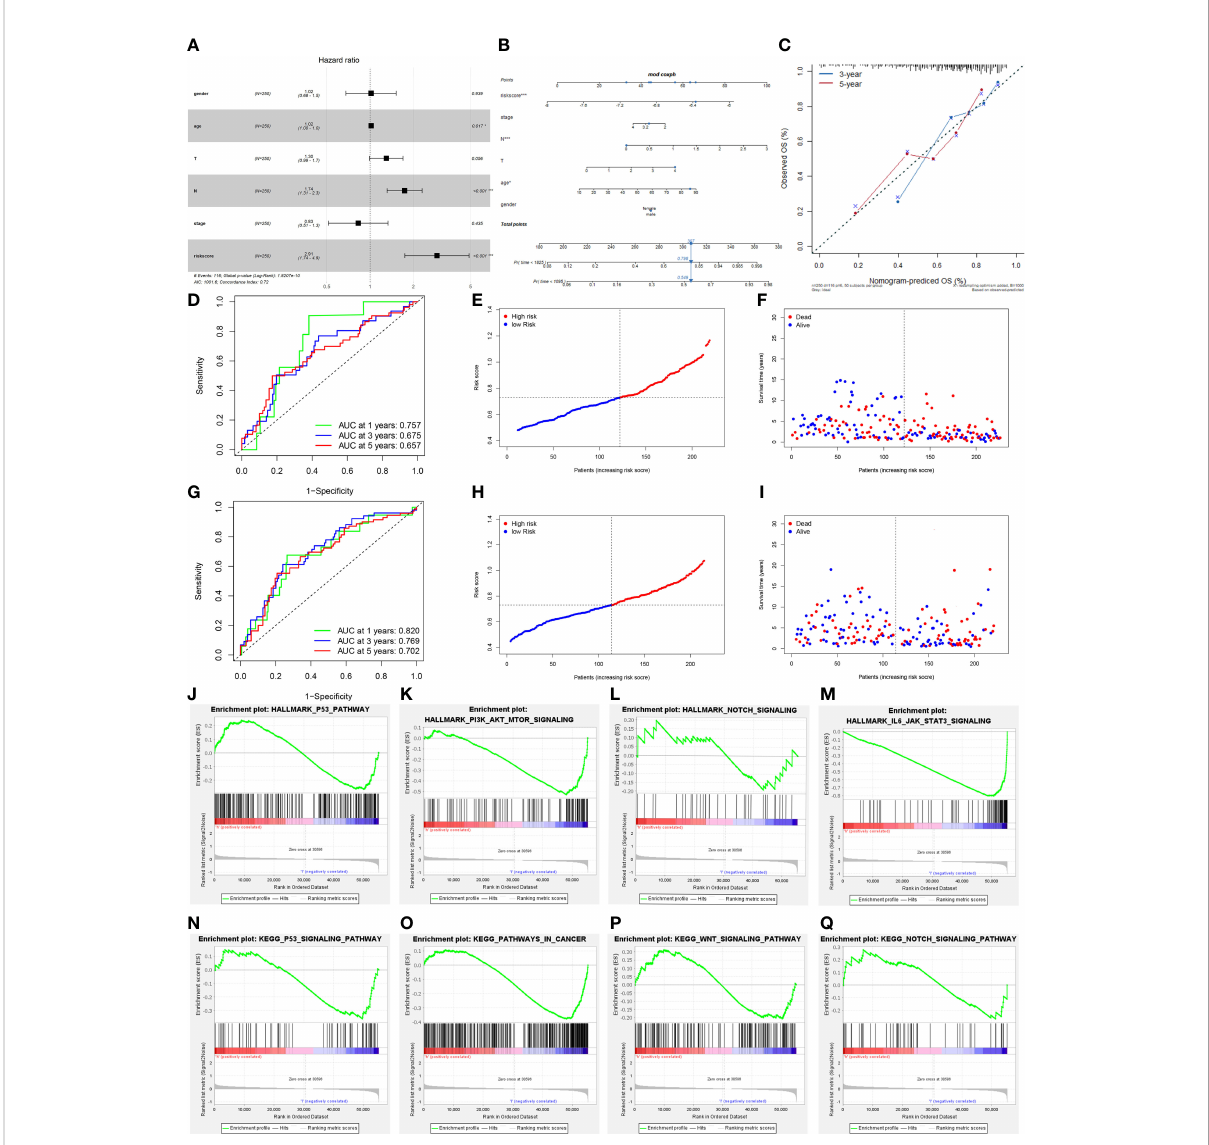
FIGURE 7 Prognostic value of the riskScore gene signature in cutaneous melanoma. (A) Forest plot. The results demonstrated that the riskScore and N were independent prognostic biomarkers using multivariate analyses. (B) The nomogram, including clinical features and the risk score, for predicting outcomes in patients. (C) The calibration curve analysis showed that the actual and the predicted 1-, 3-, 5-year survival times were consistent compared with the reference line (the 45-degree line). (D) The receiver operating characteristic curve (ROC) analysis of risk scores based on 1-, 3-, and 5-year OS in TCGA. (E) The median value and distribution of the risk score in TCGA. (F) The distribution of OS status in TCGA. (G) The ROC analysis of risk scores based on 1-, 3-, and 5-year OS in GSE54467. (H) The median value and distribution of the risk score in GSE54467. (I) The distribution of OS status in GSE54467. (J – Q) The GSEA enrichment reveal several signi fi cant signaling pathways. (J) HALLMARK P53 pathway. (K) HALLMARK PI3K AKT MTOR signaling pathway. (L) HALLMARK NOTCH signaling pathway. (M) HALLMARK IL-6 JAK STAT3 signaling pathway. (N) KEGG P53 pathway. (O) KEGG pathway in cancer. (P) KEGG WNT signaling pathway. (Q) KEGG NOTCH signaling